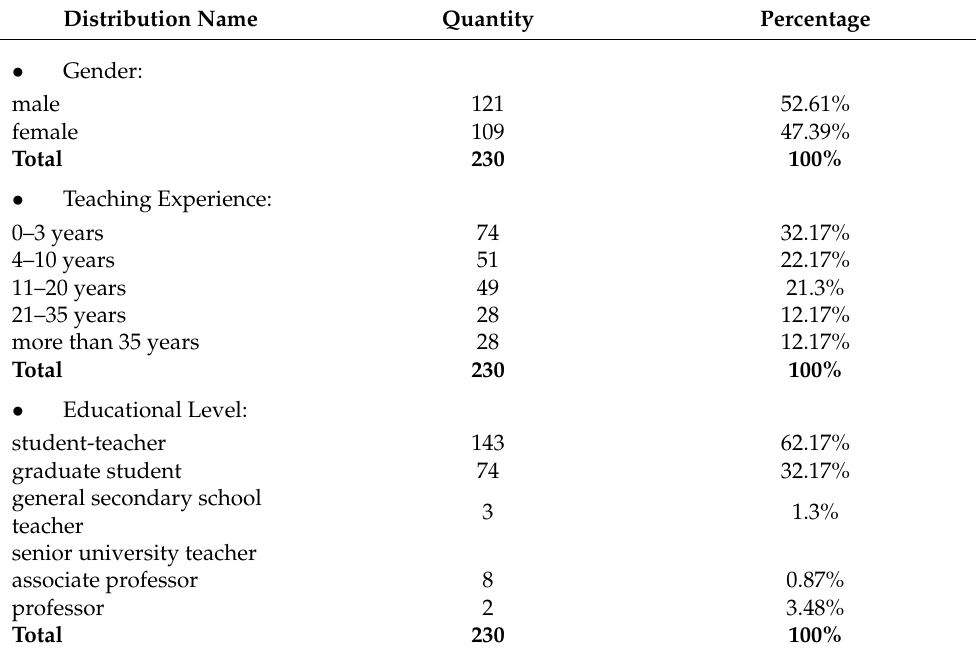
Table 1. The teaching staff’s sample distribution.